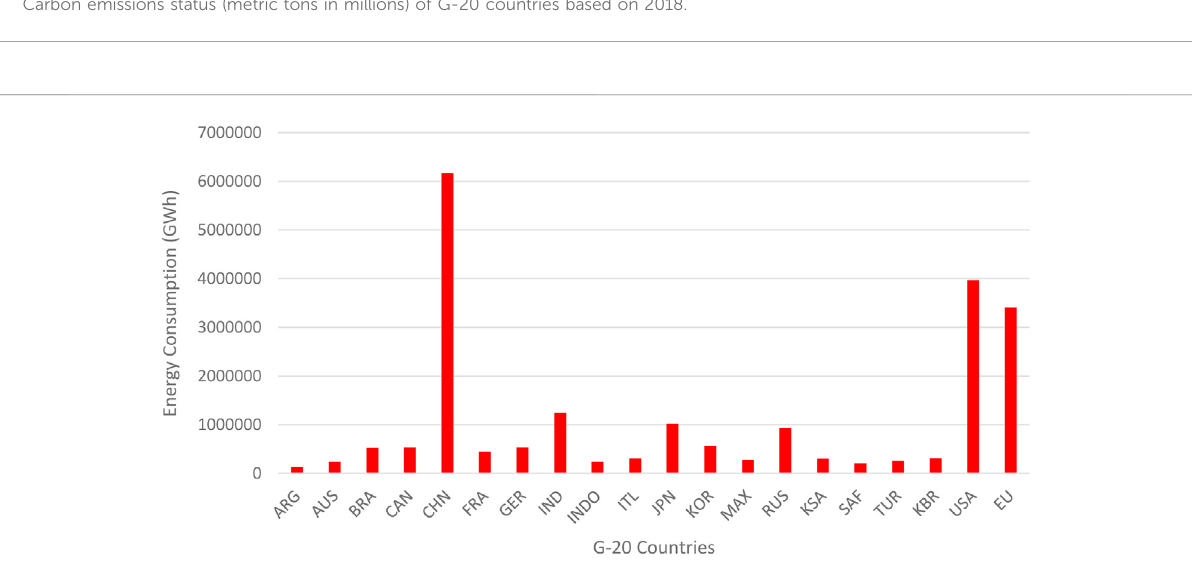
FIGURE 3 Energy consumption status [in Gigawatt hours (GWh)] of G-20 countries based on